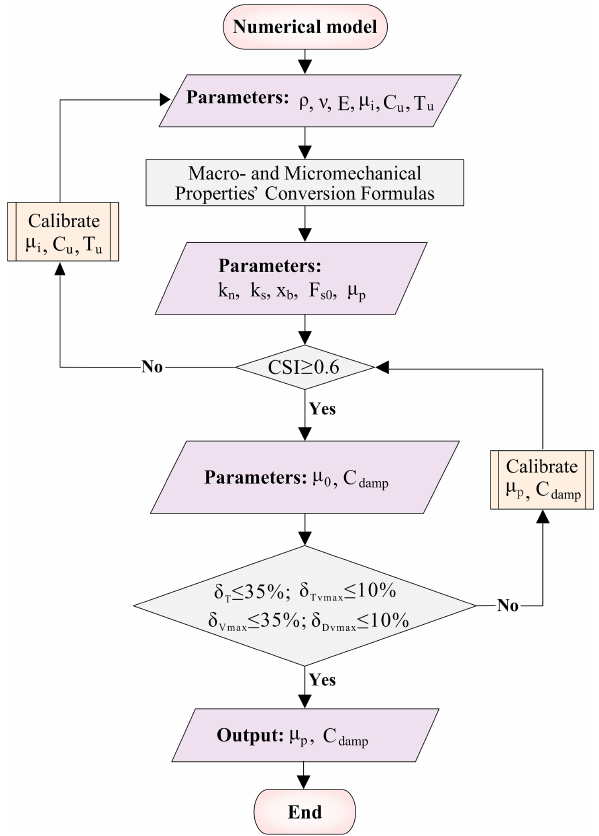
Figure 5. Flowchart of the method of discrete-element parameter adjustment based on seismic signal inversion.